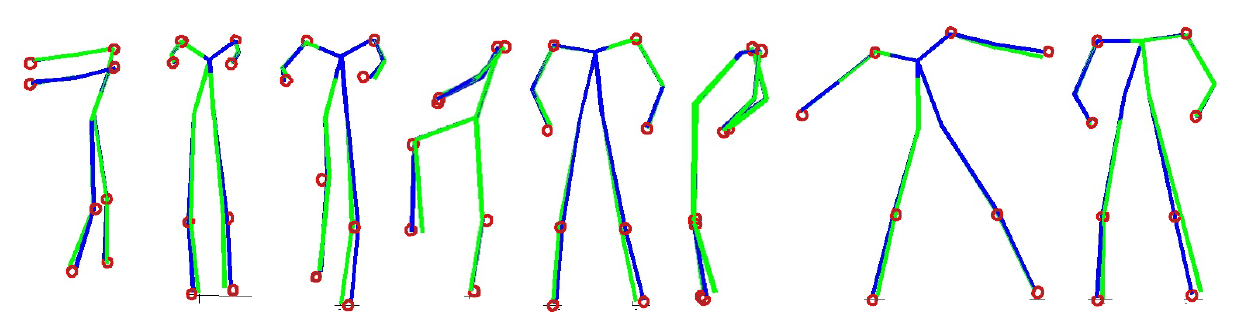
Figure 10. Examples of reconstructed poses. The red dots indicate the ground-truth positions of eight markers. The green lines are reconstruction results without pseudo-poses, and the blue lines are reconstruction results with pseudo-poses.